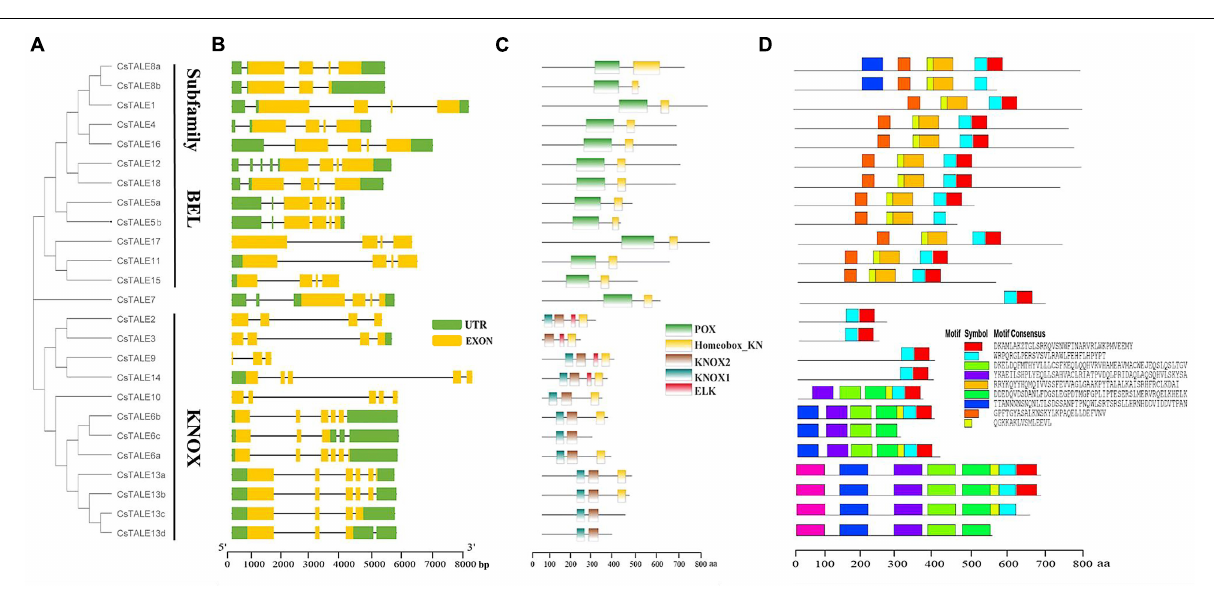
FIGURE 3 | Phylogenetic relationships and gene/protein structure of CsTALE. (A) NJ phylogenetic tree was created in MEGAX software according to the CsTALE amino acid sequence. (B) Gene structure. Exons, UTR and introns are indicated by yellow rounded rectangles, green rounded rectangles and black lines, respectively. (C) Conserved domains. Different domains are represented in different color patches. (D) Protein motif. Schematic diagram of the conserved motifs of CsTALE proteins and the motif name indicated in the bottom right corner. The scale bar at the bottom is used to estimate the sizes of protein structure and